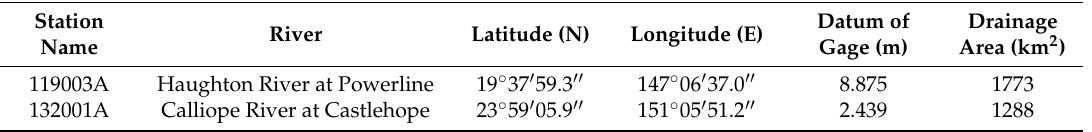
Table 1. Geographical and hydrological characteristics of the studied